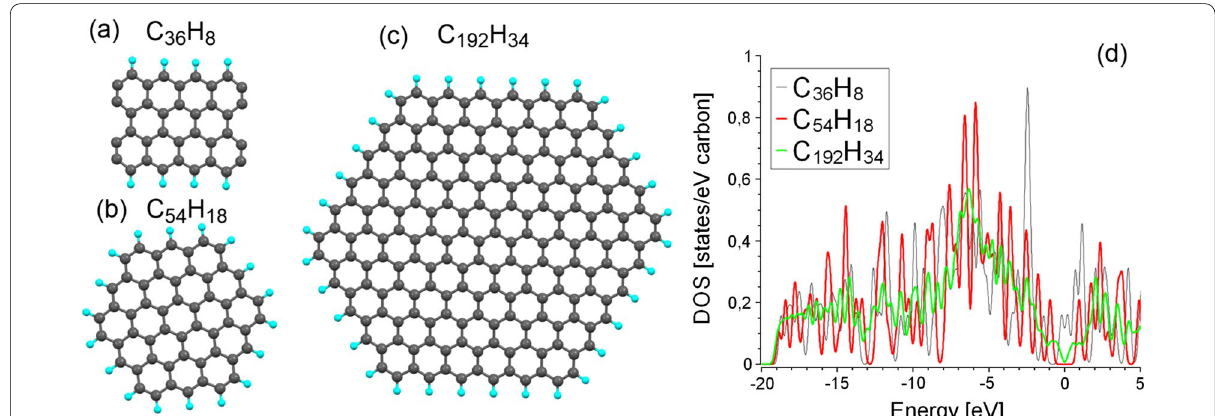
Fig. 7 Optimized atomic structure ( a – c ) and total densities of states ( d ) for selected nanographenes. Carbon and hydrogen atoms on panels a – c are shown in dark grey and cyan colors, respectively. Fermi level on panel d set as